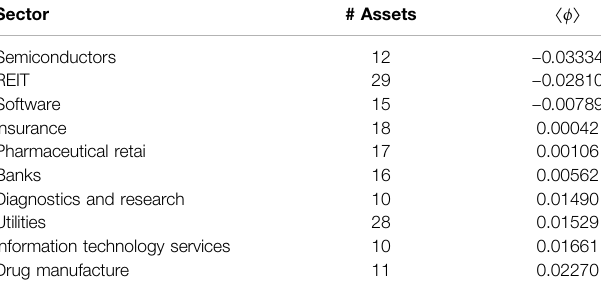
TABLE 1 | Helmholtz-Hodge potentials 〈 ϕ 〉 for some major business sectors. Sector #